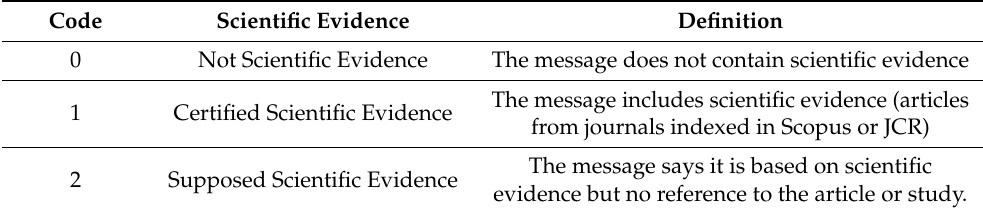
Table 2. Categories of analysis by “Scientific evidence.